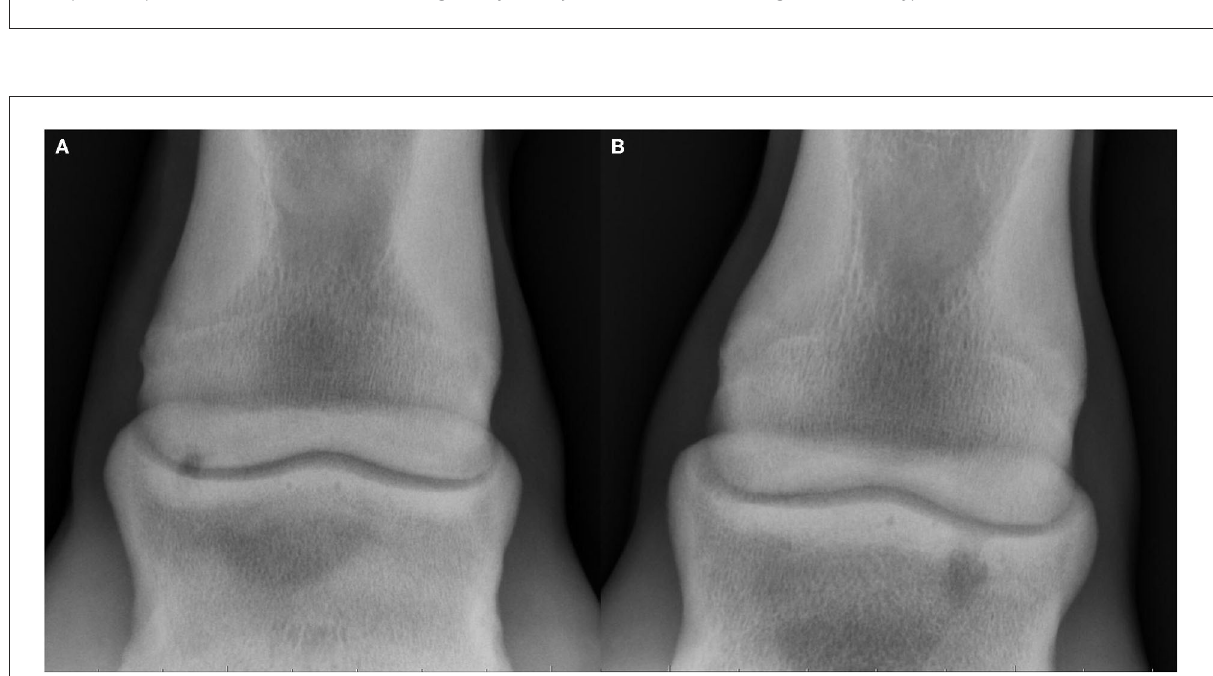
FIGURE1 Radiographs of subchondral lucencies at the distal aspect of the proximal phalanx (P1SC), dorsal and lateral are oriented at the left of the images. (A) Dorsopalmar projection showing a well-defined, columnar subchondral lucency of the distal aspect of the proximal phalanx with rim of surrounding sclerosis (subtype 3). (B) Lateromedial projection showing a well-defined, rounded subchondral lucency of the distal aspect of the proximal phalanx with narrow cloaca extending distally to the joint and rim of surrounding sclerosis (subtype 4).